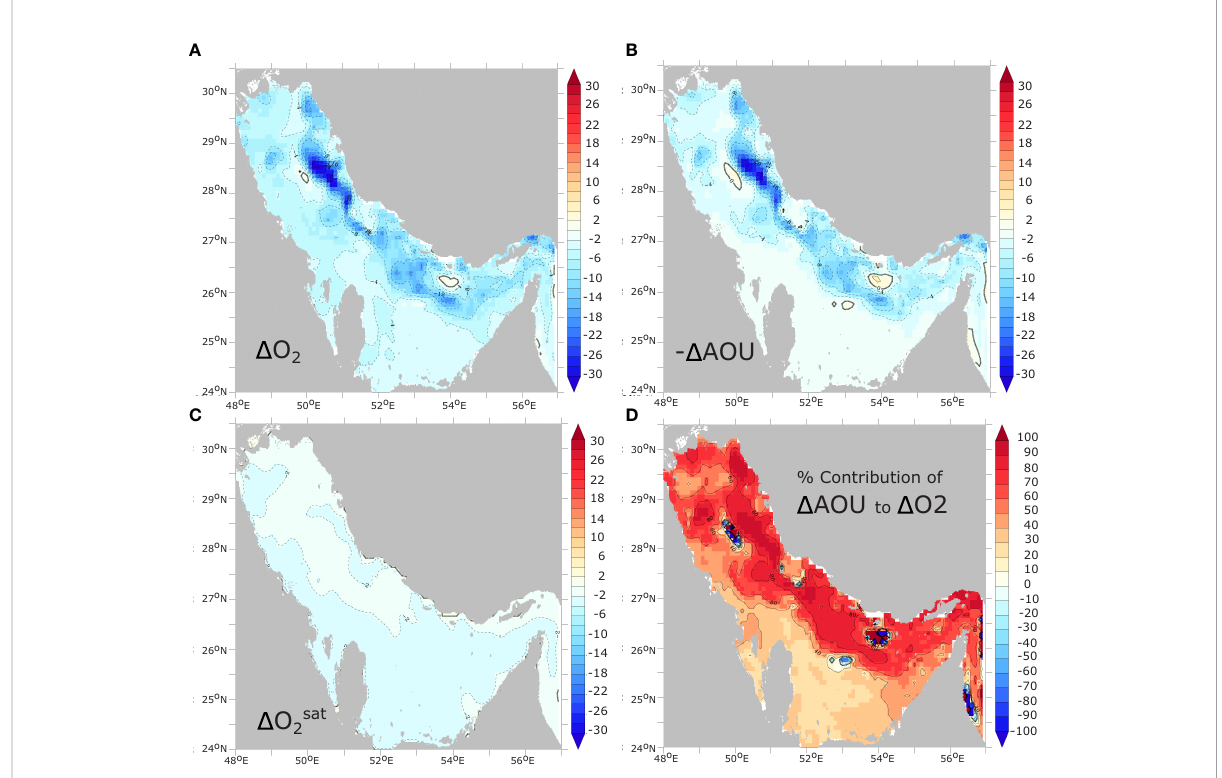
FIGURE 7 Contributions of solubility and AOU changes to near-bottom O 2 changes. Change in annual mean near-bottom (deepest model sigma layer) (A) O 2 concentrations and (B) - D AOU (- D AOU = D O 2 – D O 2sat (- D AOU) to changes in near-bottom O 2 (in